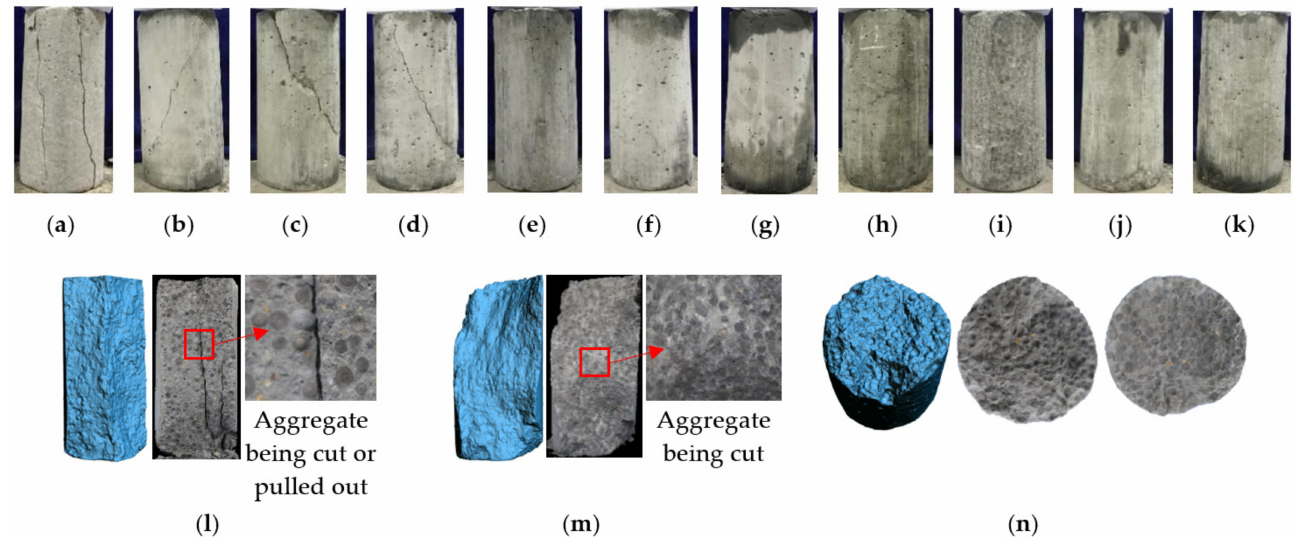
Figure 5. The typical cracking patterns. ( a ) 0 MPa, ( b ) 3 MPa, ( c ) 6 MPa, ( d ) 9 MPa, ( e ) 12 MPa, ( f ) 15 MPa, ( g ) 18 MPa, ( h ) 21 MPa, ( i ) 24 MPa, ( j ) 27 MPa, ( k ) 30 MPa, ( l ) uniaxial compression failure modes, ( m ) oblique-shear failure pattern ( σ w = 6 MPa), ( n ) oblique-shear failure pattern ( σ w = 30